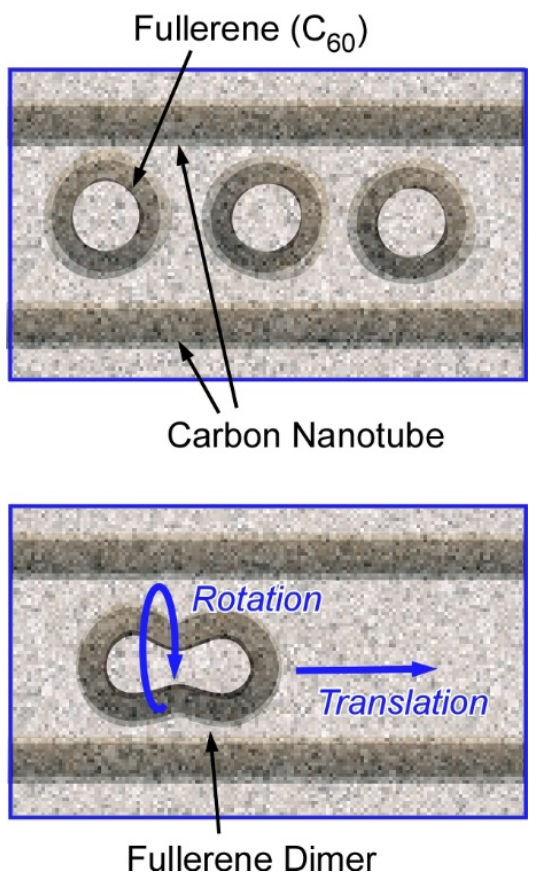
Figure 2. Nanoarchitectonics designs (models) of entrapment of fullerene molecules (C 60 molecules) within a carbon tube for single-molecule atomic-resolution real-time electron microscopic (SMART-EM) with image recording.